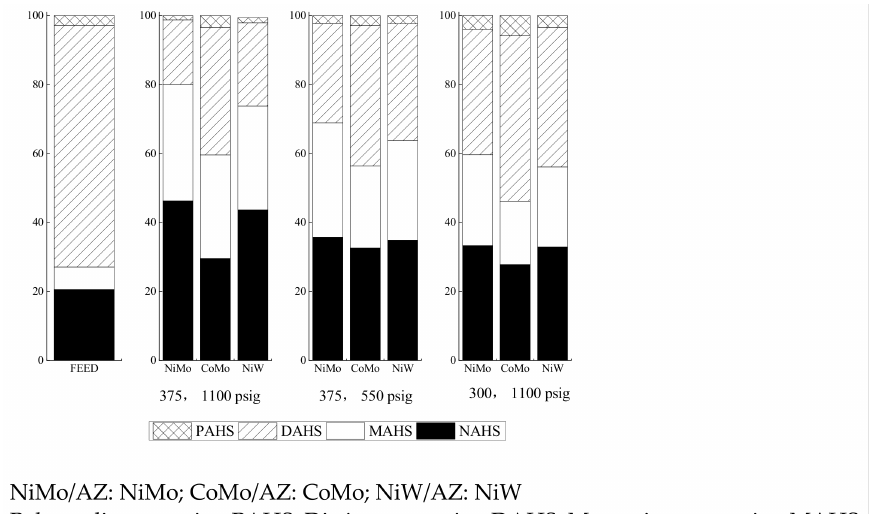
Figure 13. Hydrocarbon distributions in the final product with LCO1